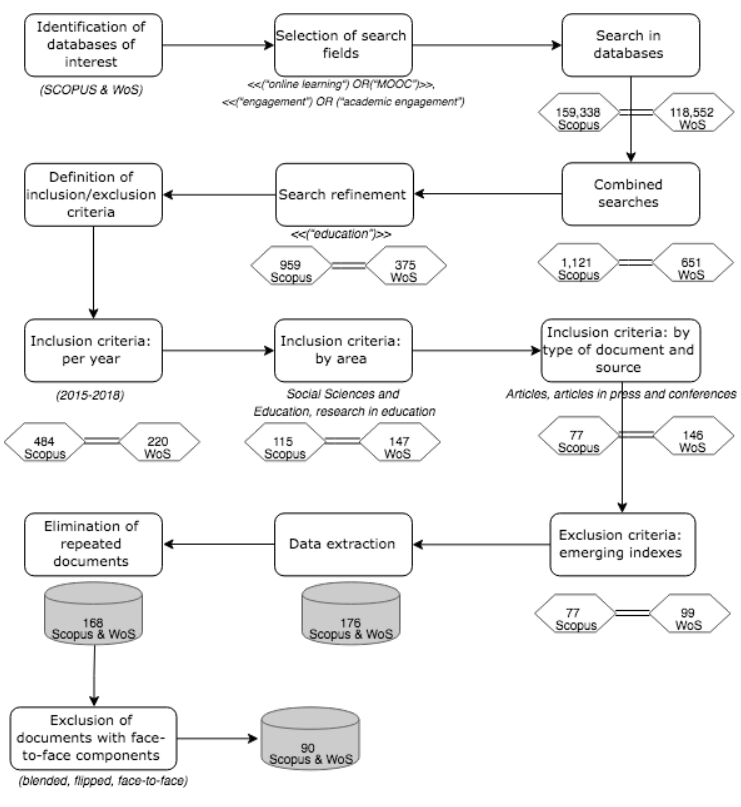
Figure 1. Flow diagram of the search